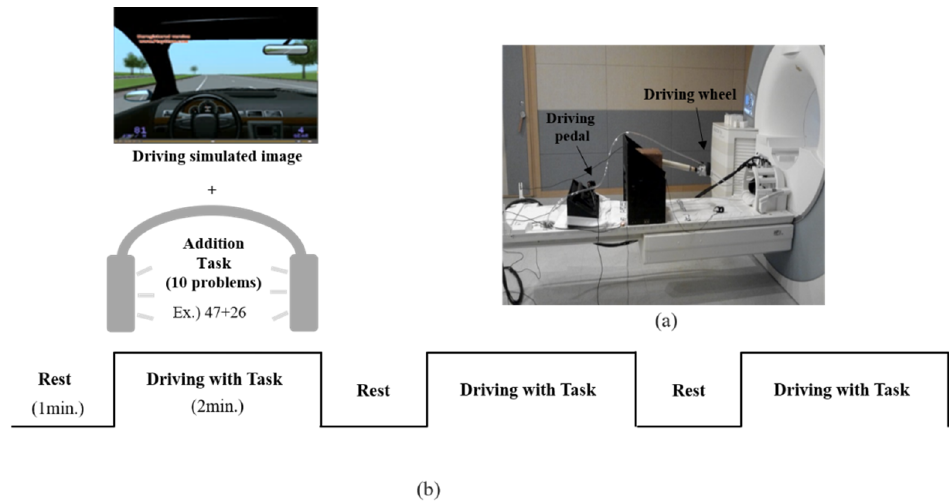
Figure 1. ( a ) MR-compatible driving simulator; ( b ) Experimental design, including driving environment and the secondary task (addition task).